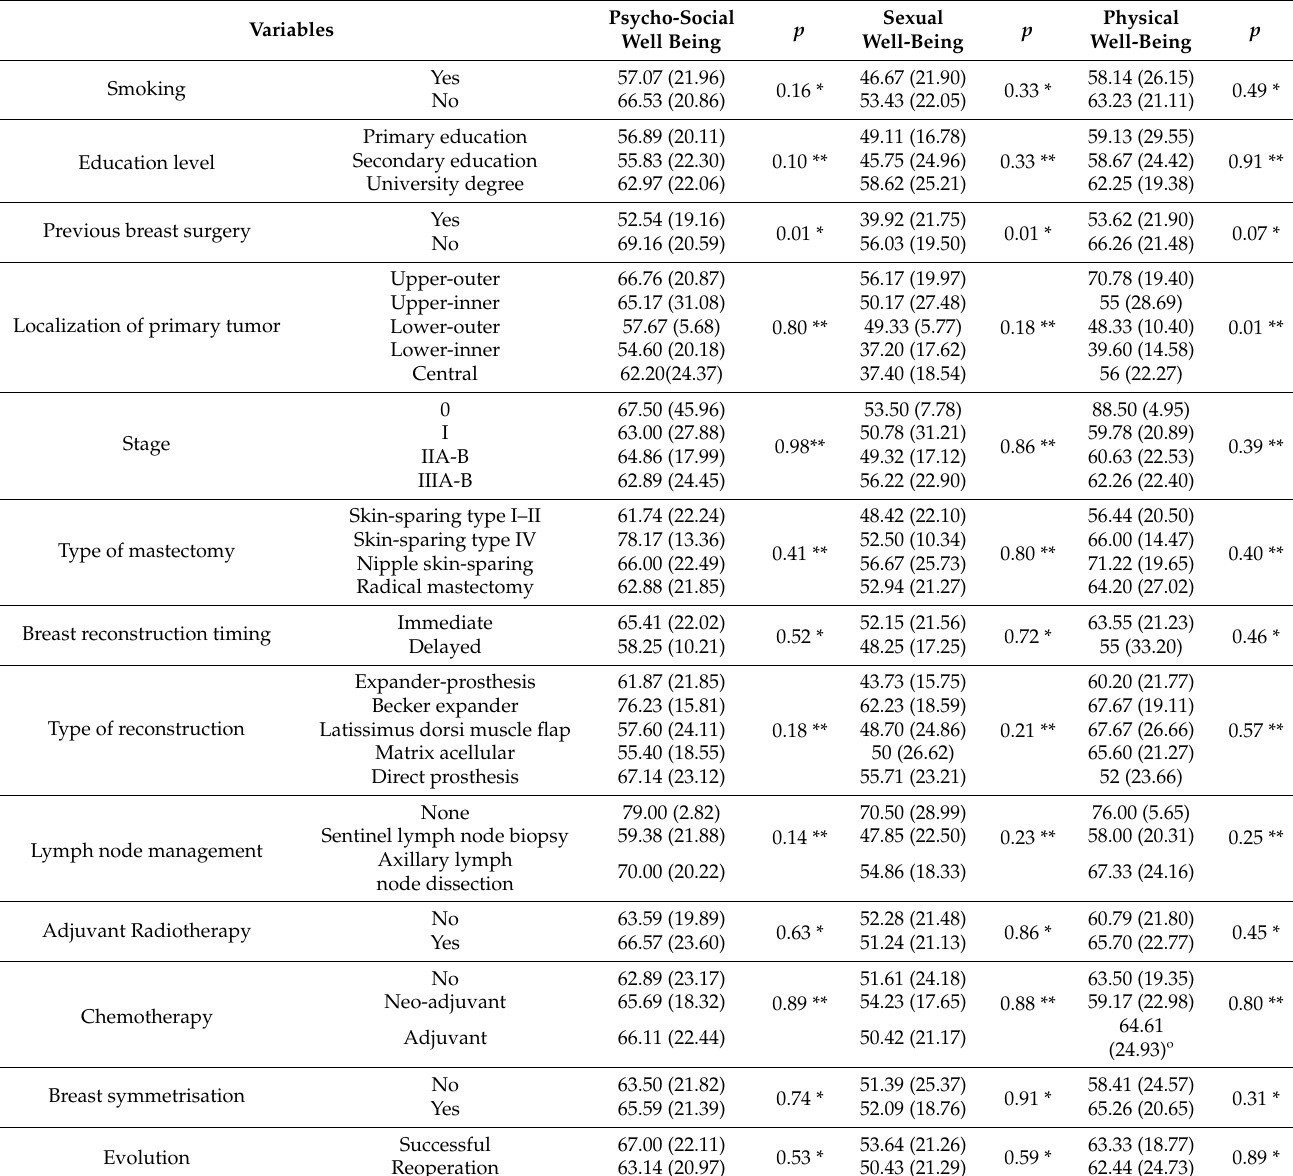
Table 5. Differences between health-related quality of life scales mean scores and qualitative variables studied.